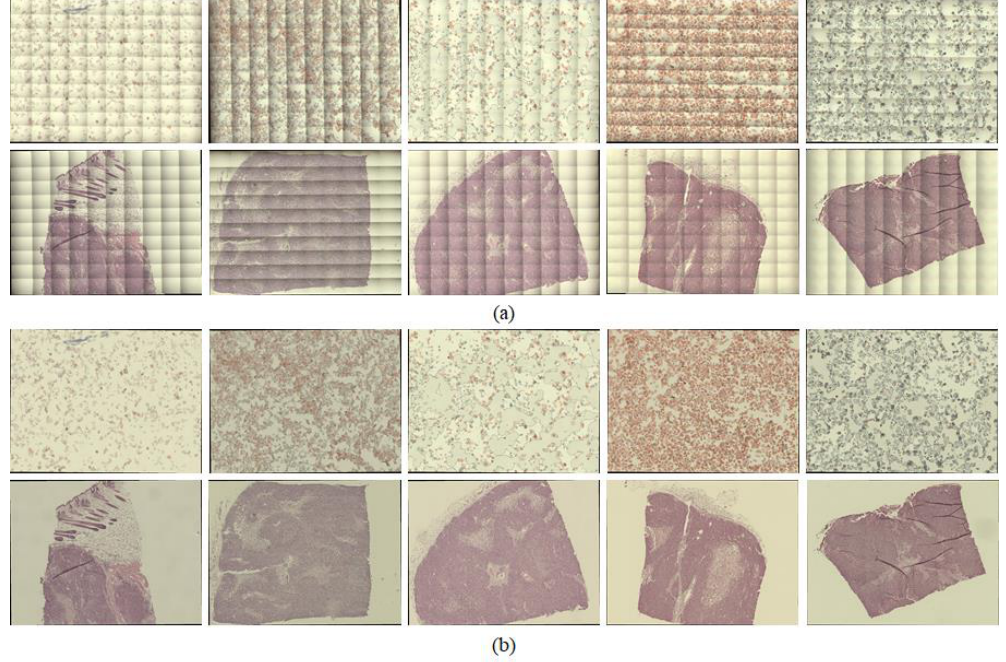
Figure 5. Examples of whole-slide images, with shading corrected by the proposed method: ( a ) whole-slide images before applying shading correction and ( b ) whole-slide images after applying shading correction.